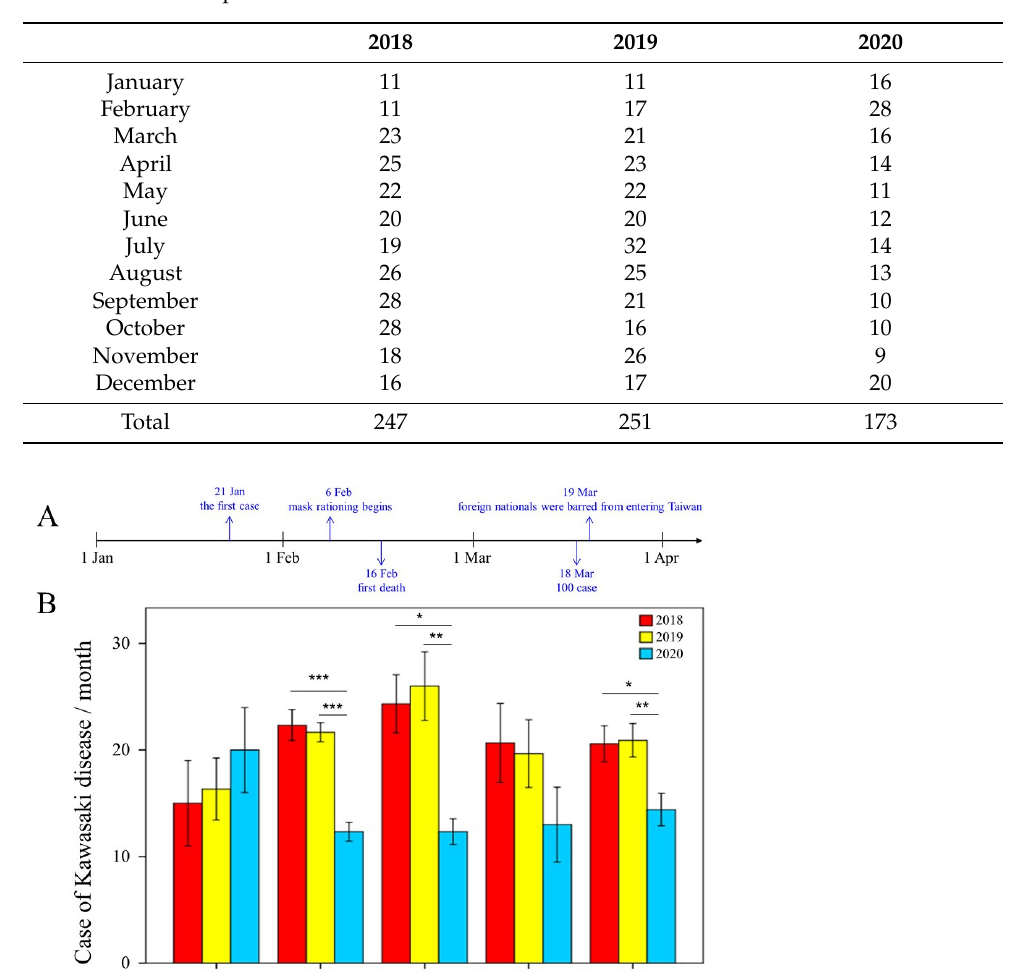
Table 1. Number of patients with Kawasaki disease.